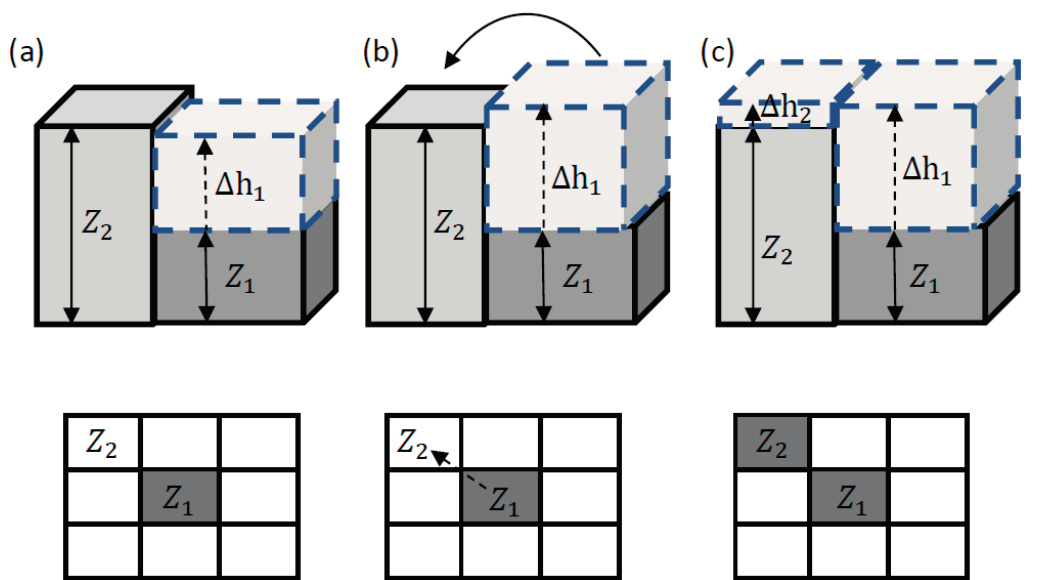
Figure 4. Water spreading using the flat-water assumption in the simplified inundation model: ( a ) A flood occurs at cell Z1; ( b ) Flood water over flows to cell Z2; and ( c ) The water surface at cells Z1 and Z2 are